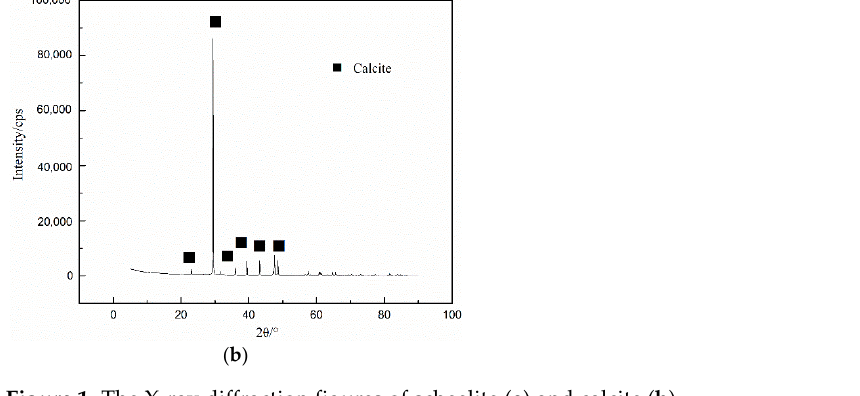
Figure 1. The X-ray diffraction figures of scheelite ( a ) and calcite ( b ). Table 1. Results of the chemical analyses of the scheelite and calcite single mineral samples. Element Content, % Purity of Sample